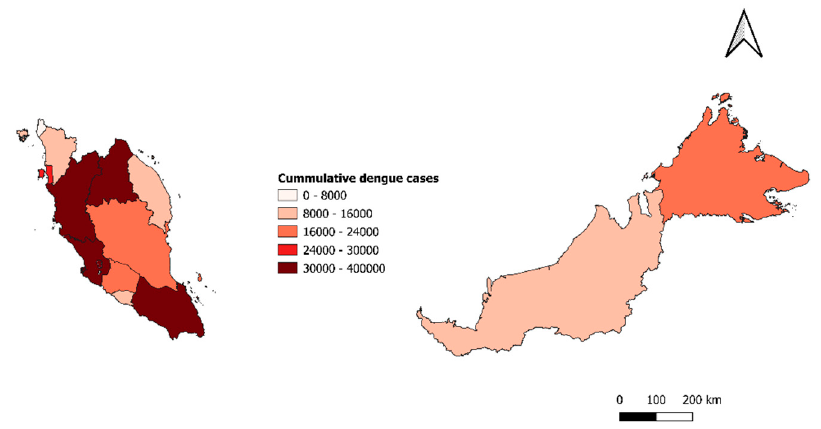
Figure A1. Cumulative dengue case by states, Malaysia 2011 to 2019.